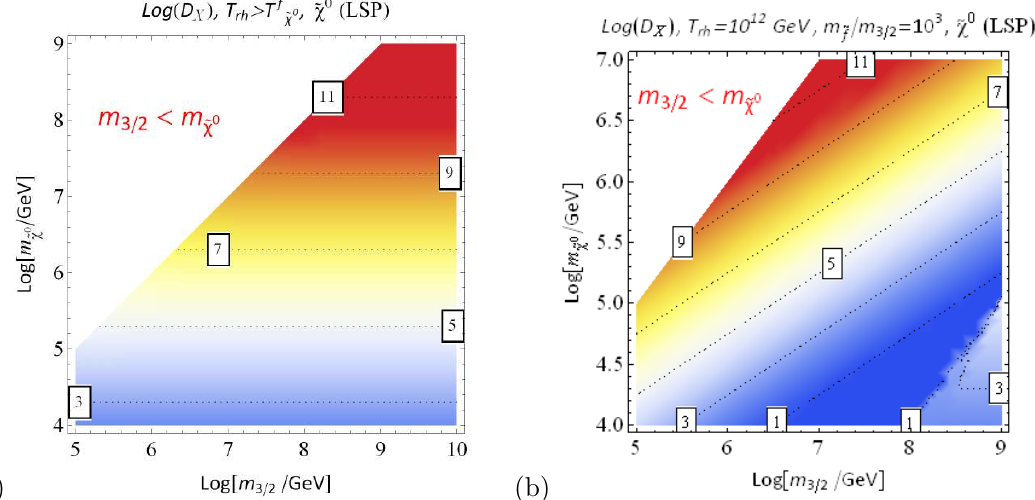
Figure 4 . Density and contour plot of the decadic logarithm of the required dilution for neutralino stable LSP. In the left panel the neutralino abundance is the thermal one. In the right the reheating temperature is T rh = 10 12 GeV the sfermions are 10 3 times heavier than the gravitinos and hence the neutralino yield is dominated by the decay of gravitinos produced from sfermion decays; in the right bottom corner of the plot the neutralinos thermalize due to large T dec . The gravitino mass is 3 = 2 taken to be m > 10 5 GeV to avoid BBN 3 = 2